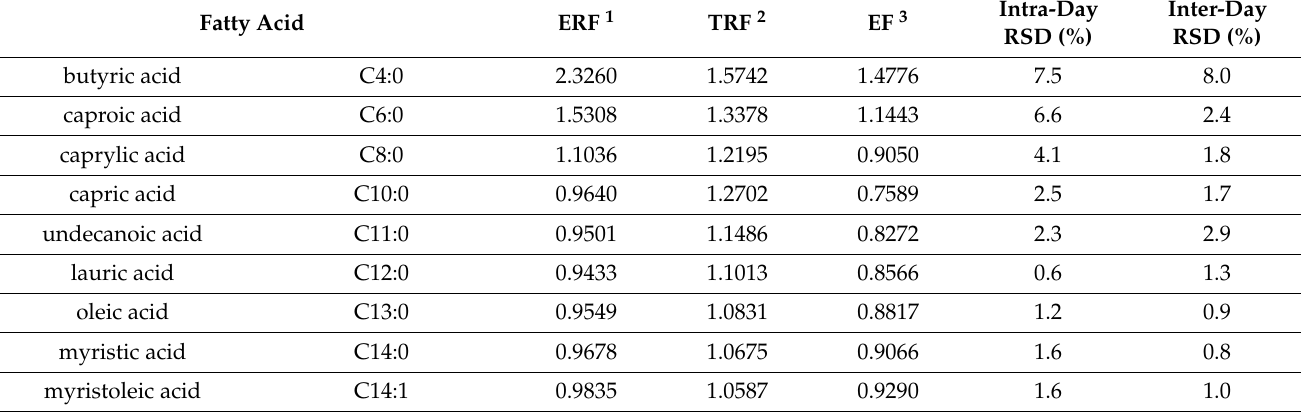
Table 1. Experimental and theoretical correction factors, error factor, intra-day, and inter-day precision for the fatty acid in milk